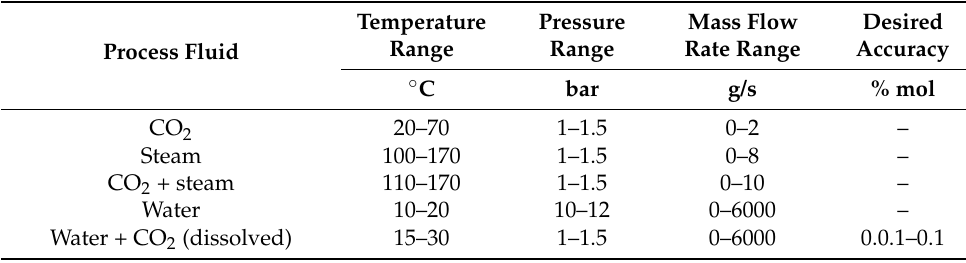
Table 3. Variability ranges of measured quantities in selected